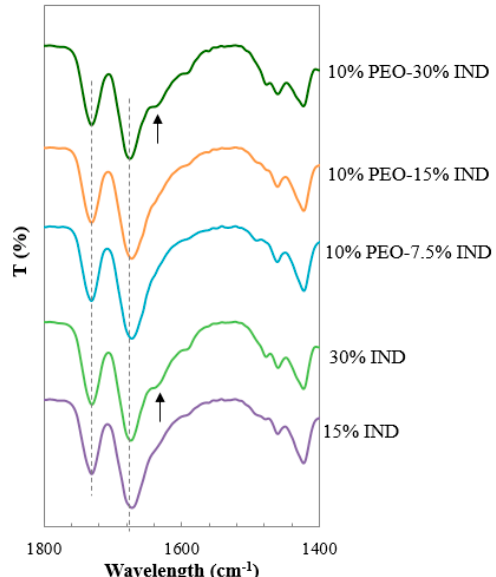
Figure 6. ATR-FTIR spectra of binary and ternary injection moulded solid dispersions PVPVA-IND and PEO. The lines mark the position of the carbonyl bands and the arrows indicate the appearance of new bands.